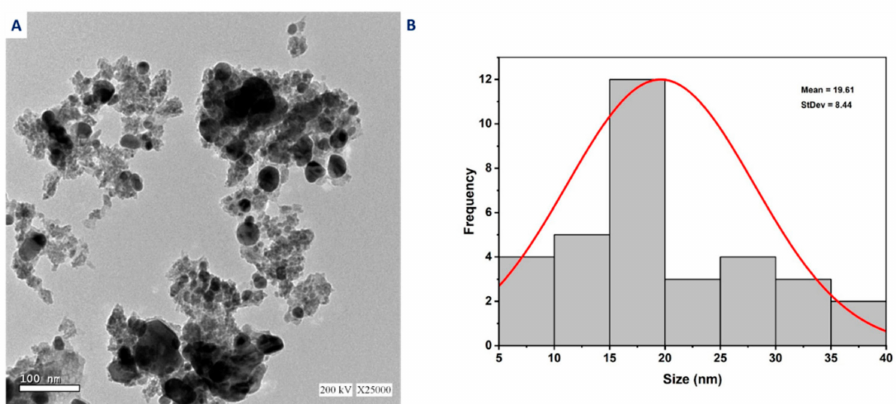
Figure 5. Characterization of MgO-NPs synthesized by A. terreus strain S1, ( A ) TEM image; ( B ) size distribution according to the TEM image.